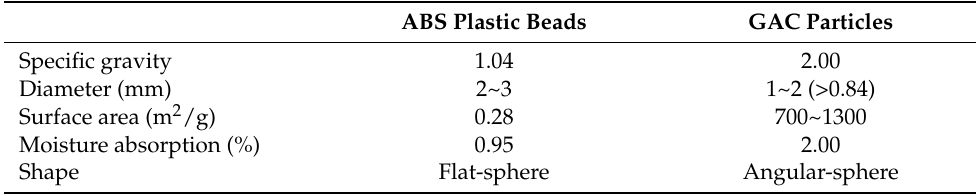
Table 1. Characteristics of fluidized media.